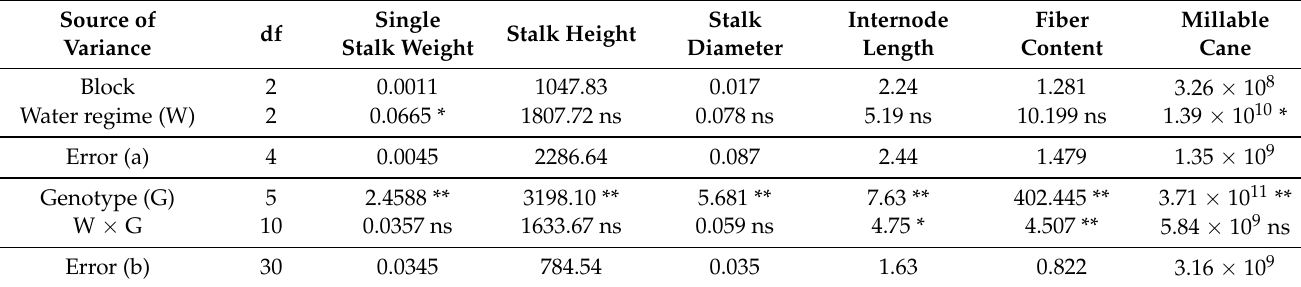
Table 9. Mean squares for single stalk weight, stalk height, stalk diameter, internode length and fiber content of six sugarcane genotypes under early drought